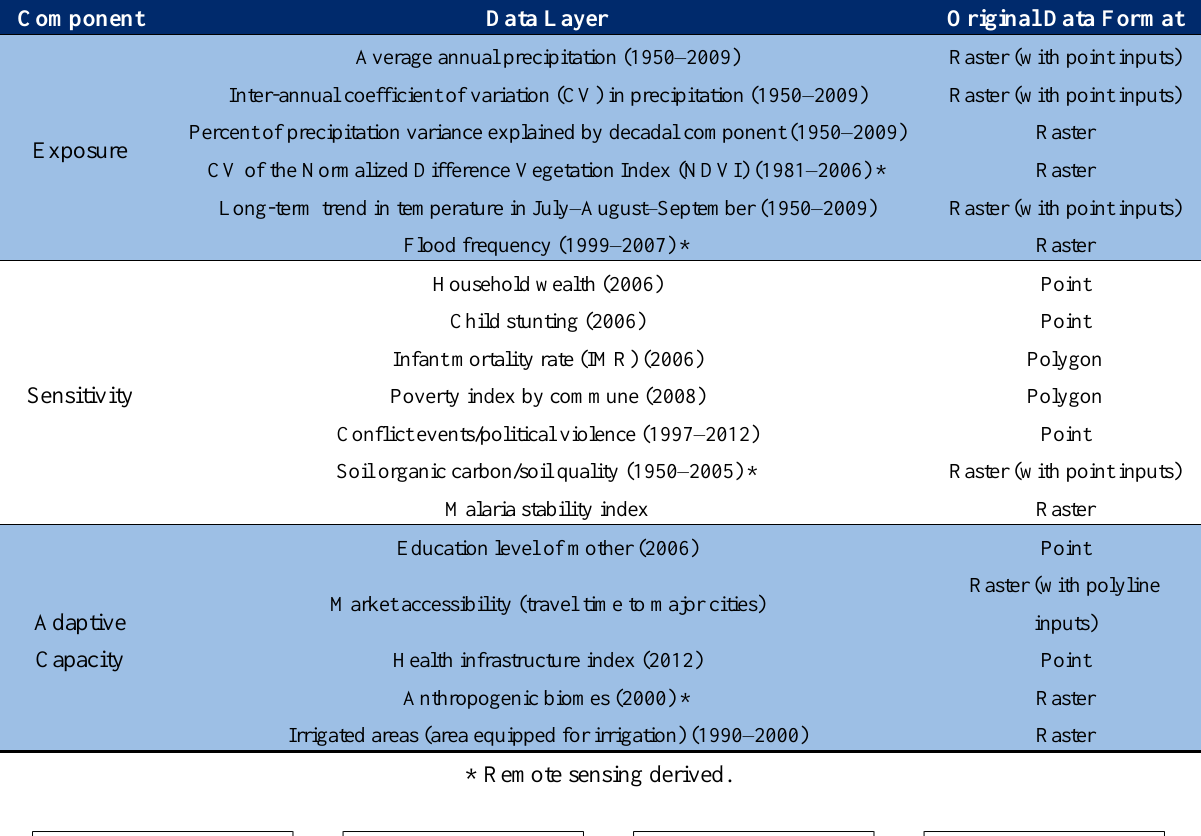
Table 1. Indicators used for the Mali climate vulnerability mapping exercise.